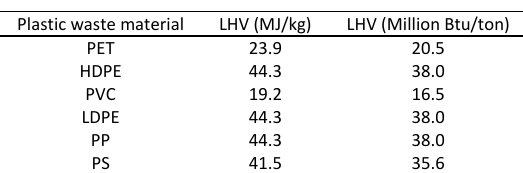
Table 3: Low heating value of plastic materials (Themelis and Mussche, 2014)